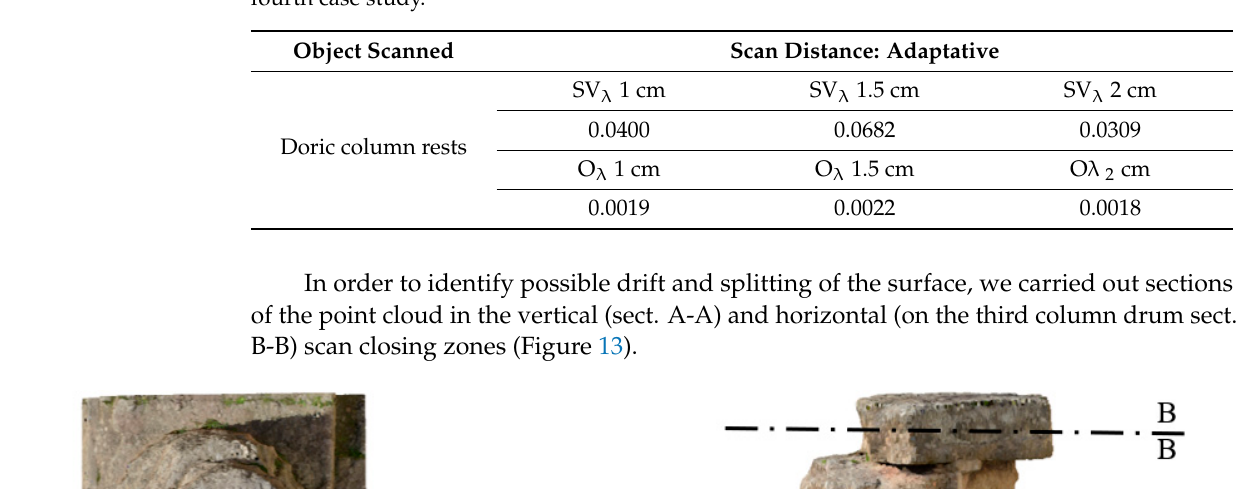
Table 6. Surface variation and omnivariance values of the point cloud of the rests of the column, fourth case study.